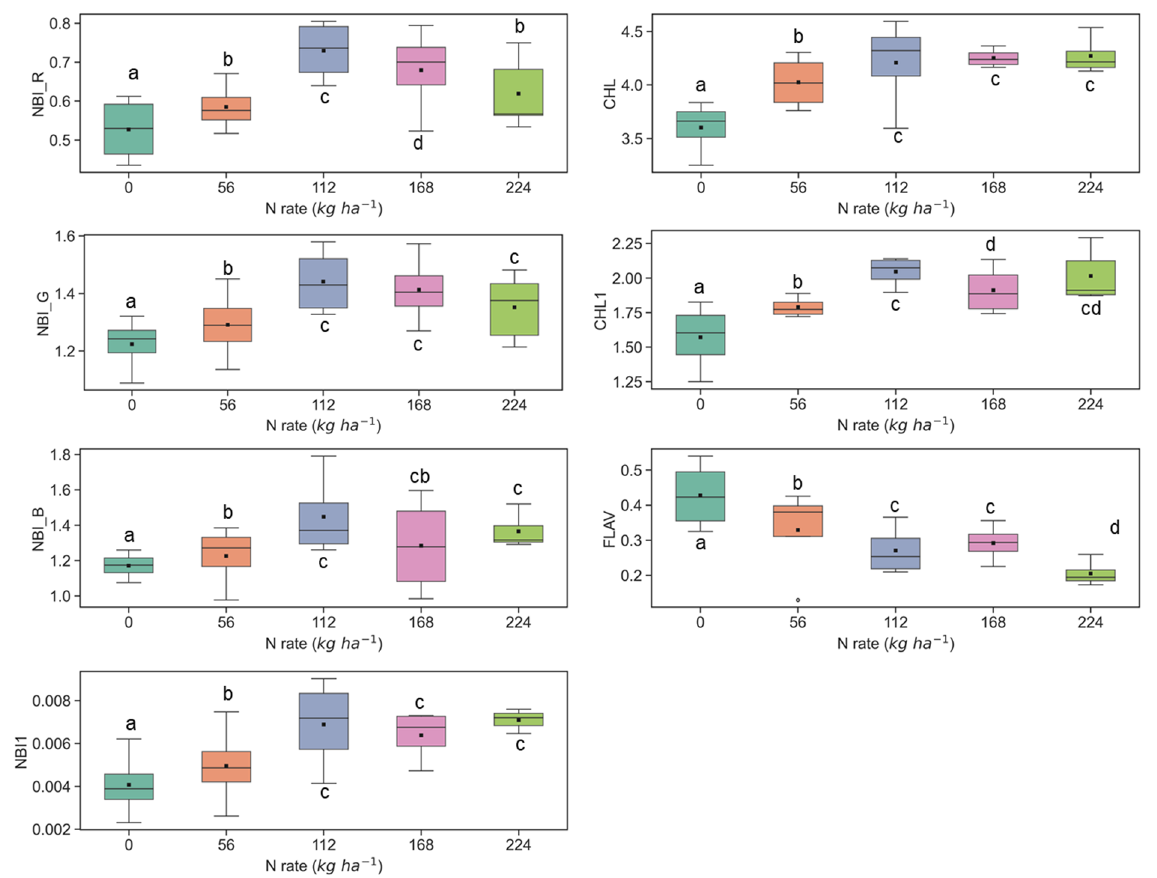
Figure 4. Response of Multiplex fluorescence indices over maize canopy treated with different N application rates at the V9 growth stage at the ARDEC site. Different letters (a, b, c, d) designate significant differences according to the Tukey’s HSD test at p < 0.05 significance level.